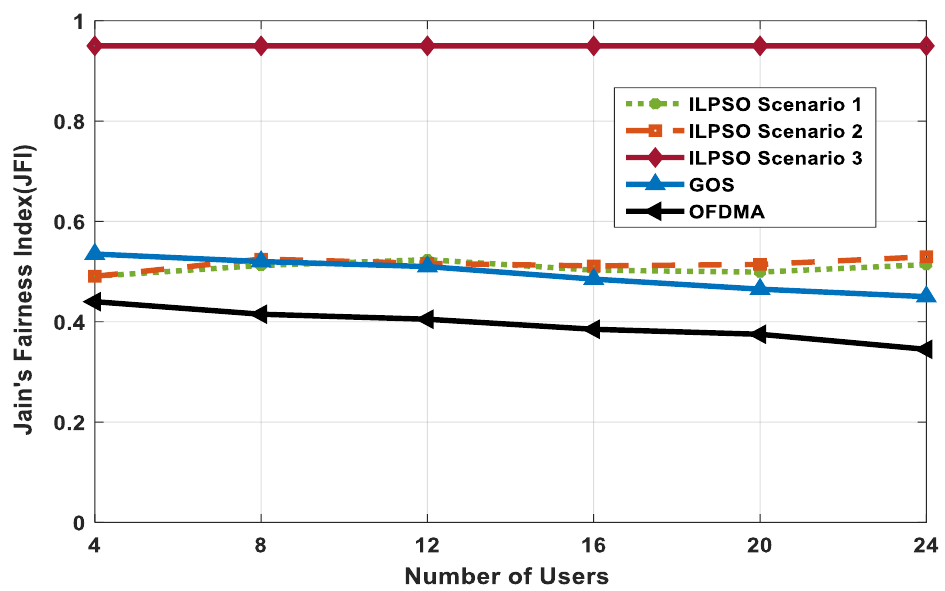
Figure 3. Achieved Jain’s fairness vs. the number of users.